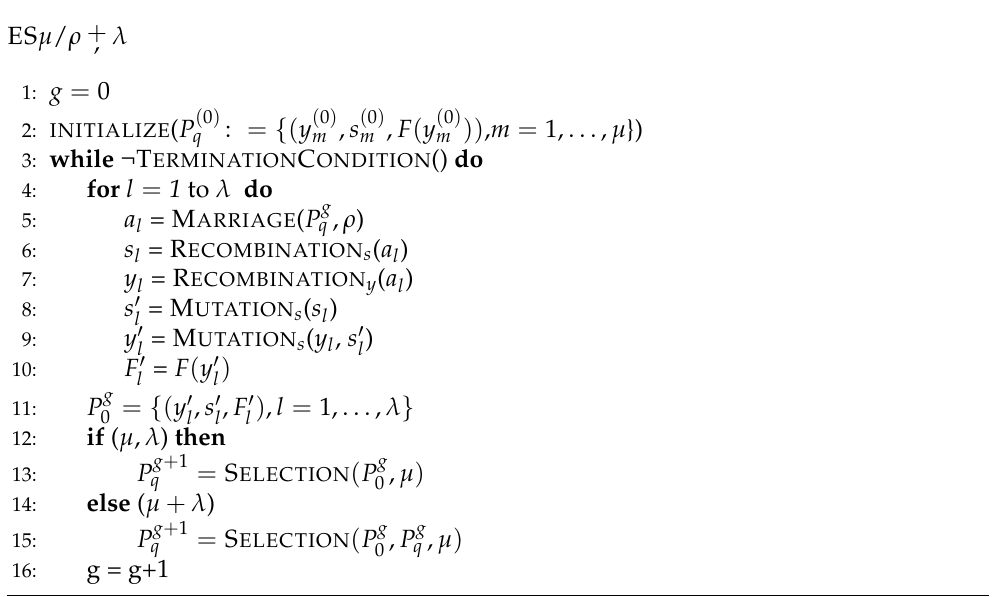
Algorithm 11 Evolutionary strategies described by